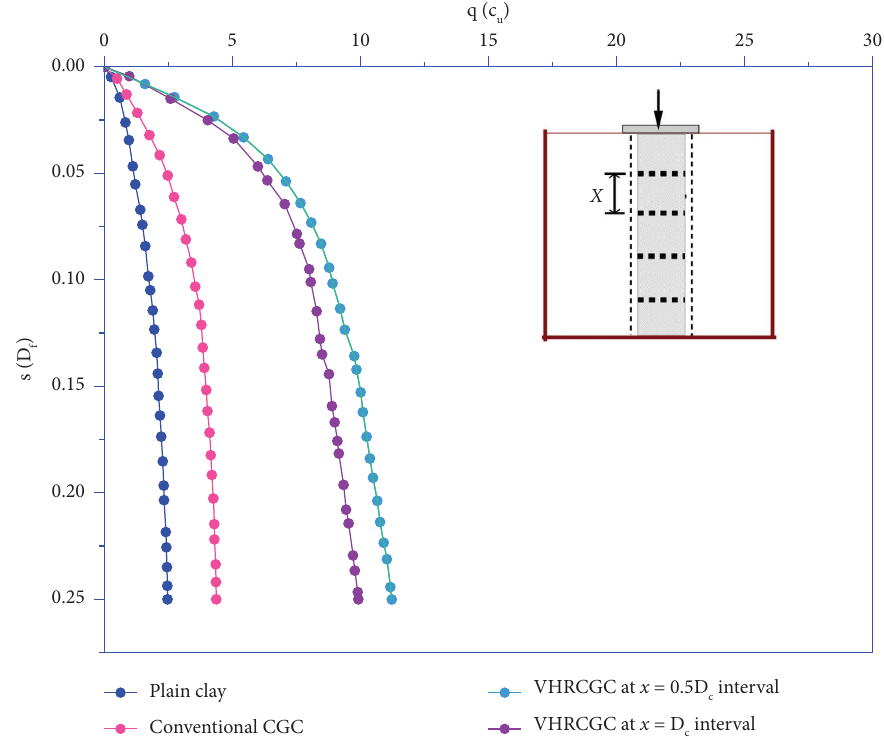
Figure 18: q / q u versus s / D f curve for ECGC having horizontal reinforcement at various depths.